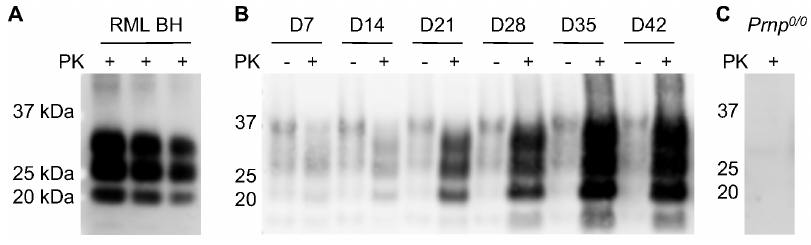
Figure 1. Immunoblots of PrP Sc in cerebellar slice cultures infected with RML strain. A) The typical banding pattern of RML-infected brain homogenate (RML BH) inoculum after proteinase K (PK) digestion is shown. 10, 5, and 2 m g total protein were loaded. B) RML-infected POSCA slices were homogenized in pairs in RIPA buffer, then 30 m g total protein was treated with 20 m g/mL PK for one hour ( + ). Undigested slice culture homogenates ( 2 ) were loaded at 10x lower concentration for comparison. PrP Sc is distinguished by its truncated state after PK digestion, seen as lower molecular weight bands when compared with PrP C . PrP Sc can also been seen to increase in amount with increasing culture time (days 7 through 42 are shown). C) RML-treated POSCA slices from Prnp 0/0 mice did not show PrP Sc at any time point. Day 45 is